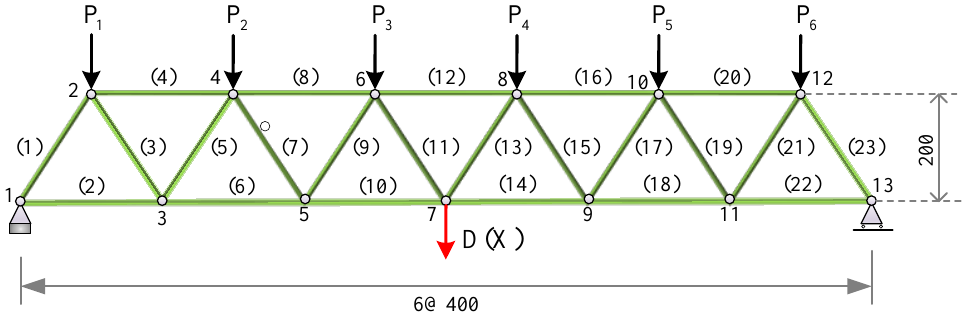
Figure 8. Schematic diagram of truss structure in Example 4. Table 8. Basic random variables in Example 4.